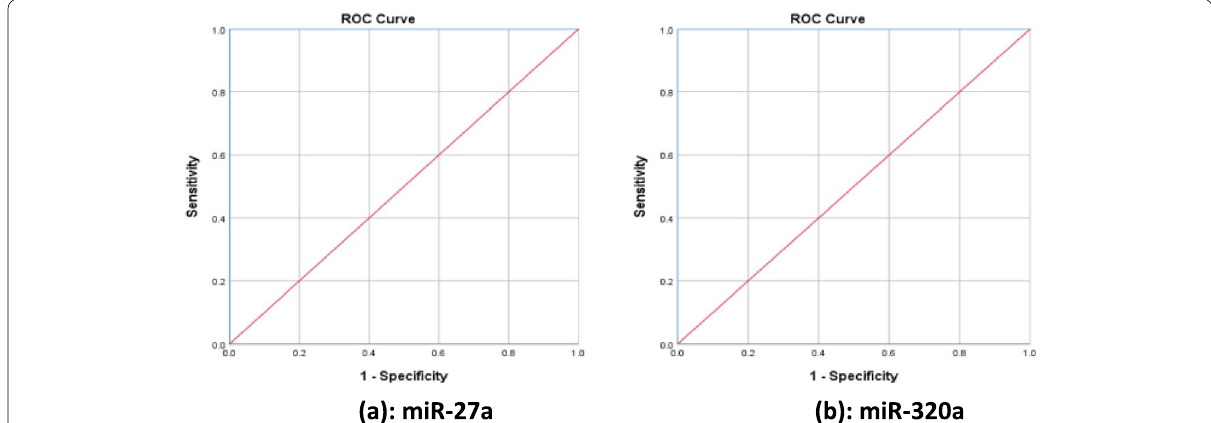
Fig. 2 a , b ROC curve of Rq of miR‑27a ( AUC from metabolic syndrome